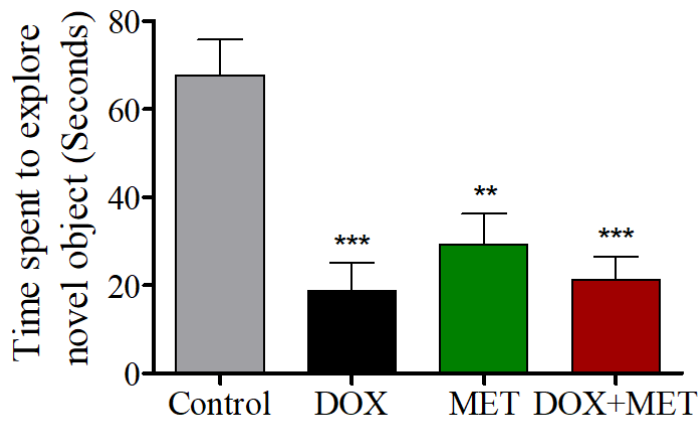
Figure 3. E ff ects of DOX and MET on novel object Figure 3. Effects of DOX and MET on novel object recognition. Figure 3. Effects of DOX and MET on novel object recognition.